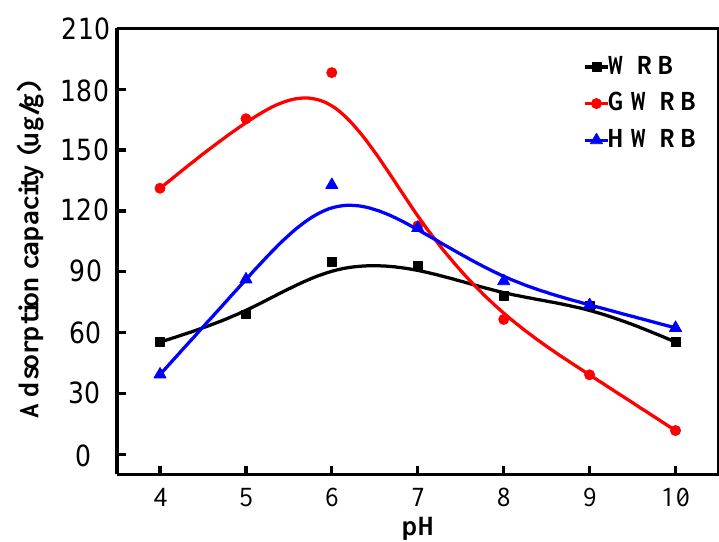
Figure 6. The e ff ect of pH on the adsorption of cimetidine onto WRB, GWRB, and HWRB. Figure 6. The effect of pH on the adsorption of cimetidine onto WRB, GWRB, and HWRB.